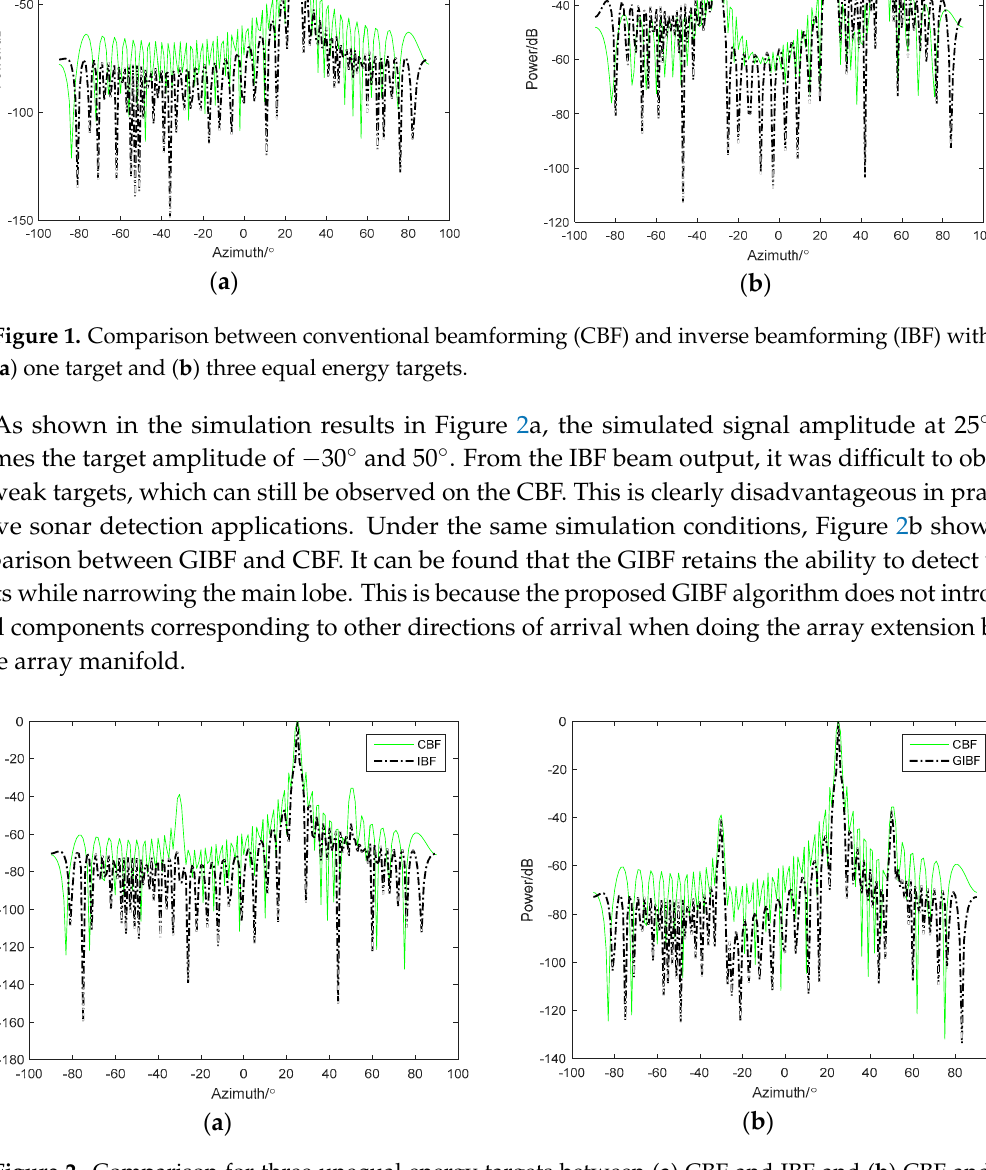
Figure 1. Comparison between conventional beamforming (CBF) and inverse beamforming (IBF) with ( a ) one target and ( b ) three equal energy targets.